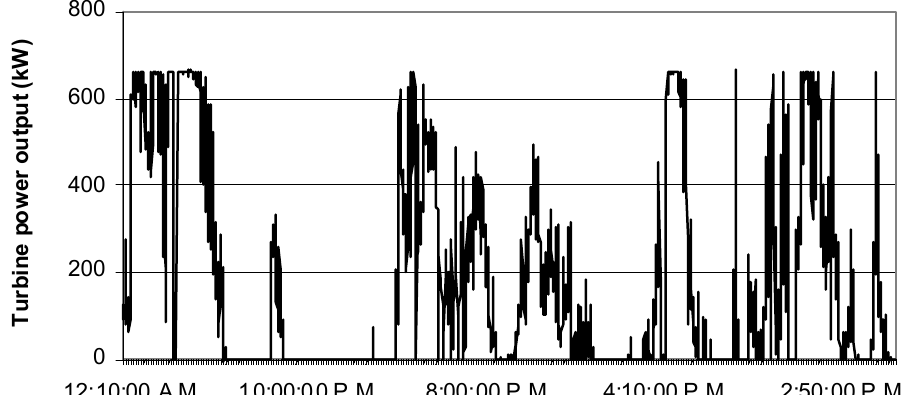
Figure 3. Turbine output power variation during the one month monitoring